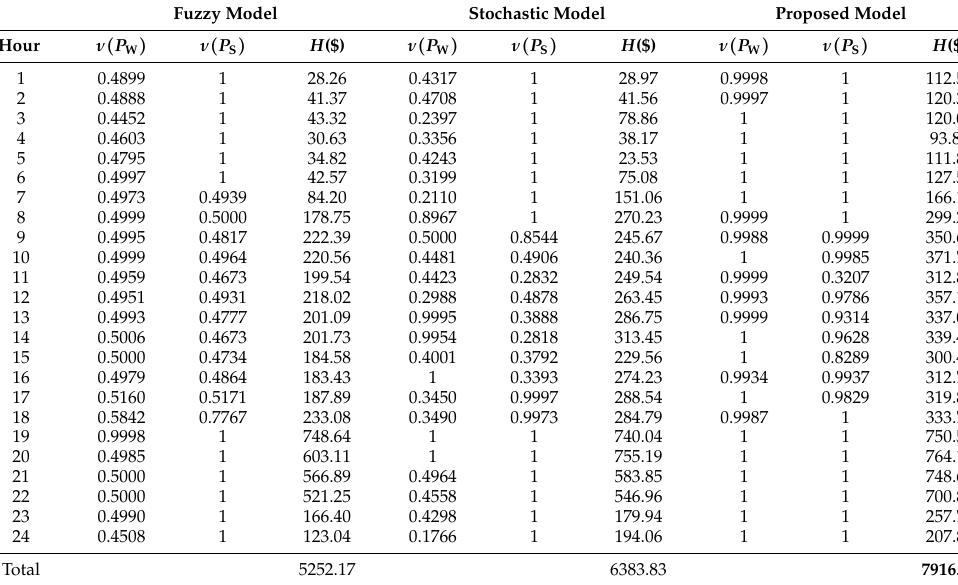
Table 6. Comparison of fuzzy model, stochastic model, and the proposed model.